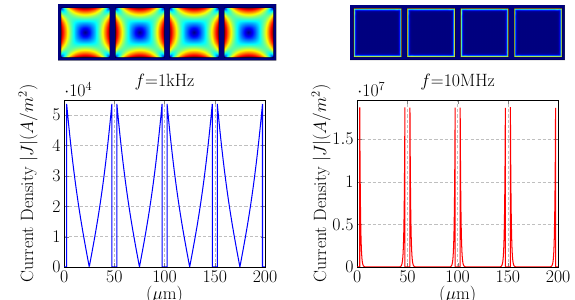
Figure 2: EC distributions in a SMC microstructure at 1kHz and 10MHz (horizontal center